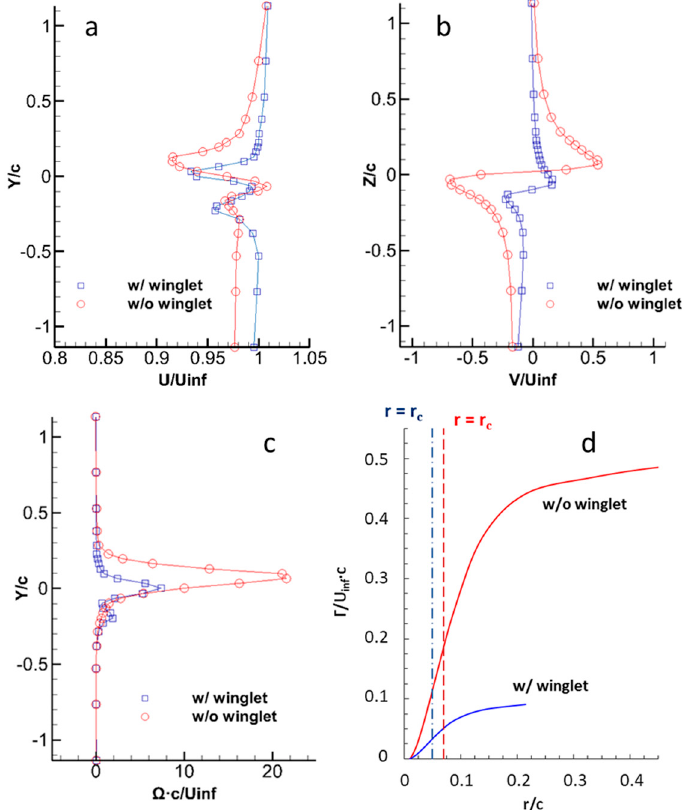
Figure 20. Time-averaged axial ( a ) and normal velocity ( b ), vorticity ( c ) and circulation ( d ), with and without winglet.